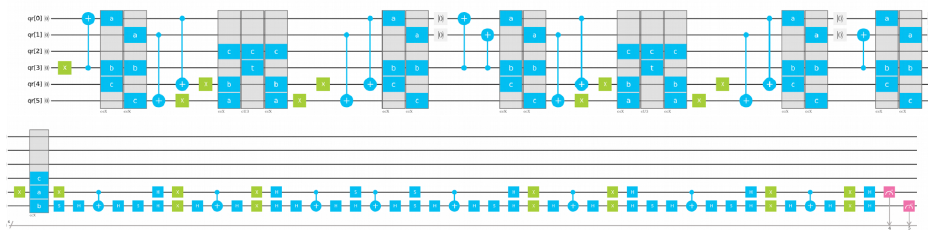
Figure 6: The end-to-end QuAM circuits prodeced by the Qiskit-based circuit generator prototype for (top): saving three 2-bit patterns and (bottom): retrieving one 2-bit